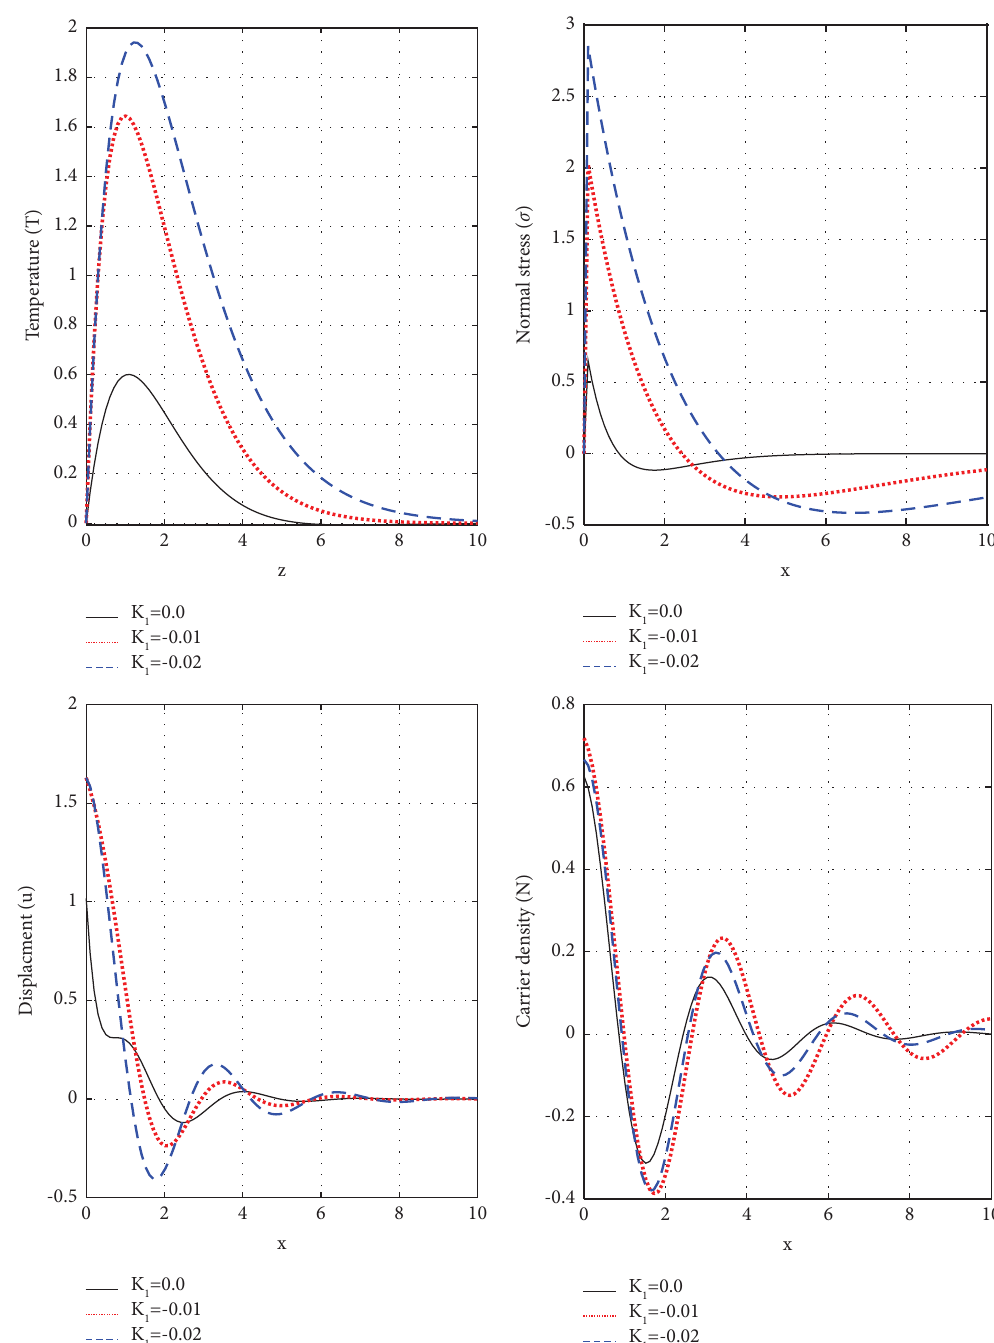
Figure 4: Te variation of physical felds verses the axial distance according to the DPL model with variable thermal conductivity in the absence of holes carrier charge